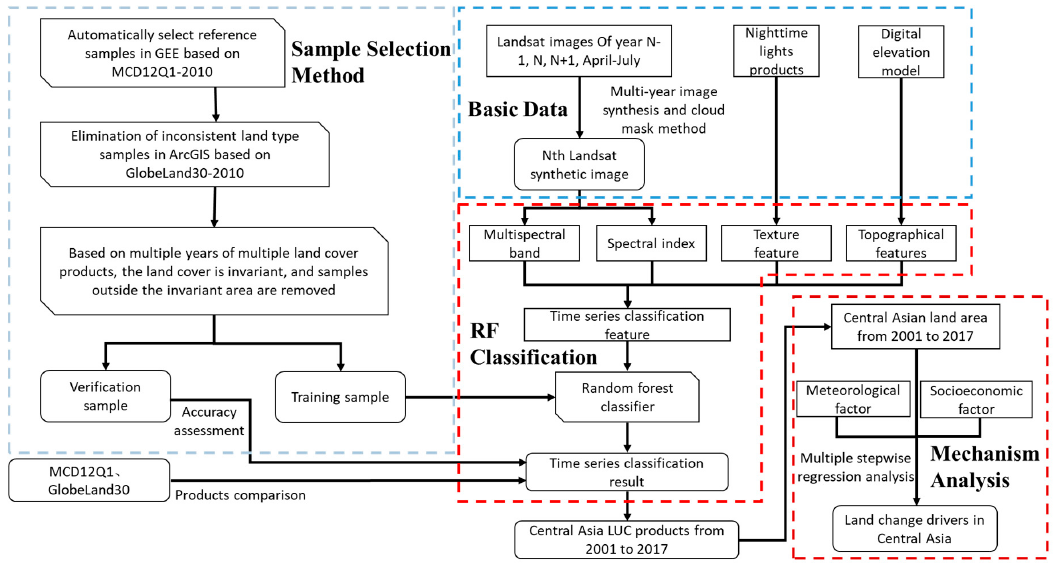
Figure 2. Flowchart of land cover mapping and mechanism analysis. Land cover mapping includes sample selection, basic data and RF classification. Note that LUC represents land use/cover.